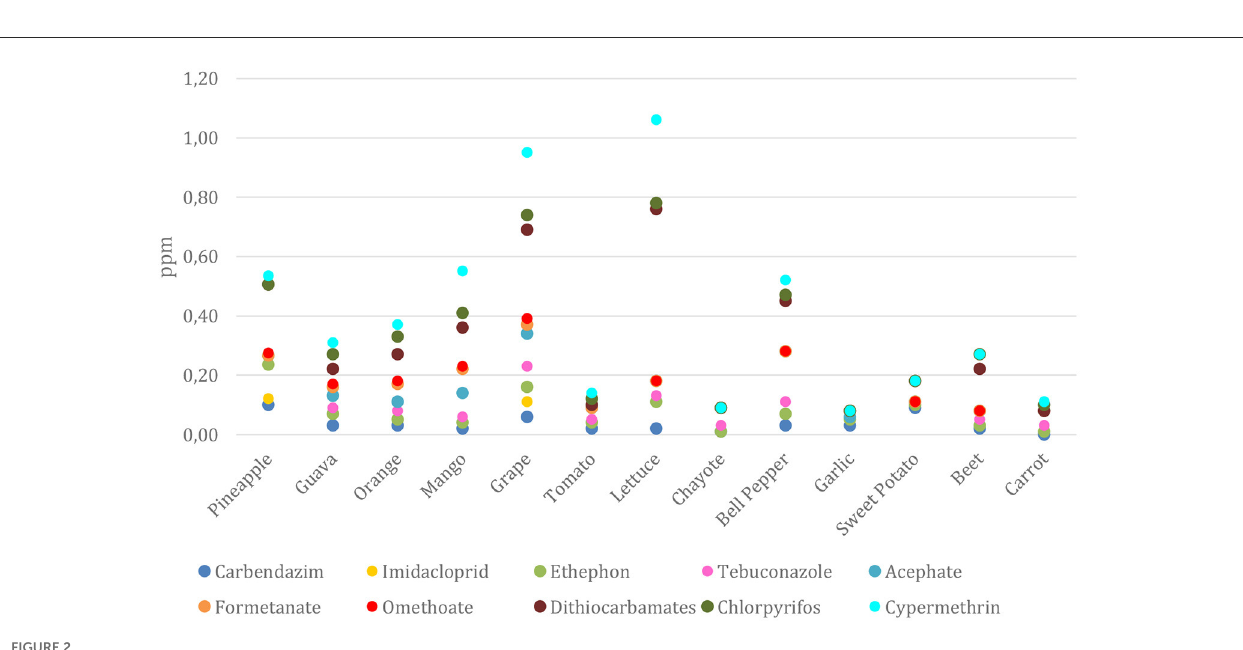
for the Theoretical Maximum Daily Intake (TMDI) (Equation 1) considers the Maximum Residue Limits (MRL) (28) to establish the highest level of pesticides legally tolerated on food or feed crops. For MRL, we only considered the compounds authorized for use in Brazil since the current guidelines of the National Health Surveillance Agency (Anvisa) do not cover unauthorized products. The daily intake of any particular pesticide residue in a given food is obtained by multiplying the residue level in the food (MRL) by the amount consumed (F).